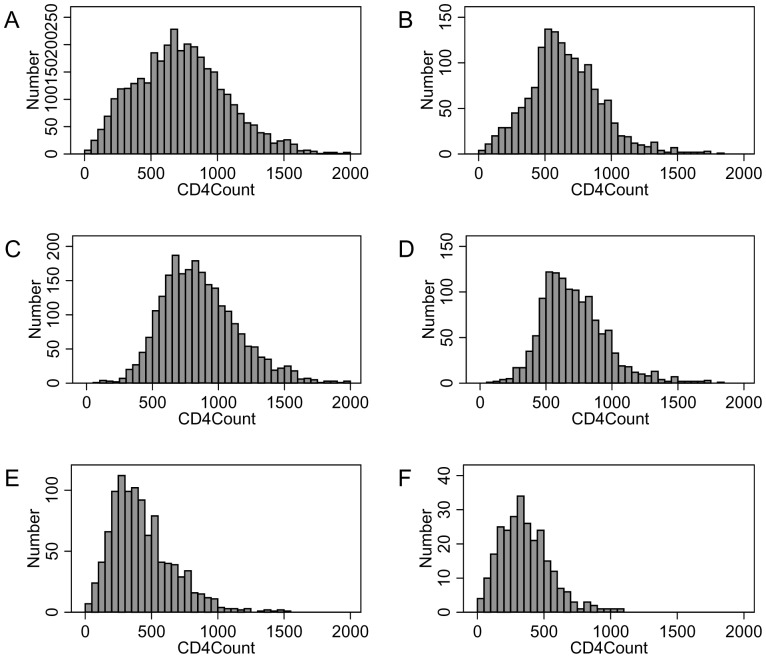
Histogram of CD4 count distributions in the study population by HIV infection status.Total female (A) and male (B) participants; HIV-uninfected female (C) and male (D) participants; HIV-infected female (E) and male (F) participants.